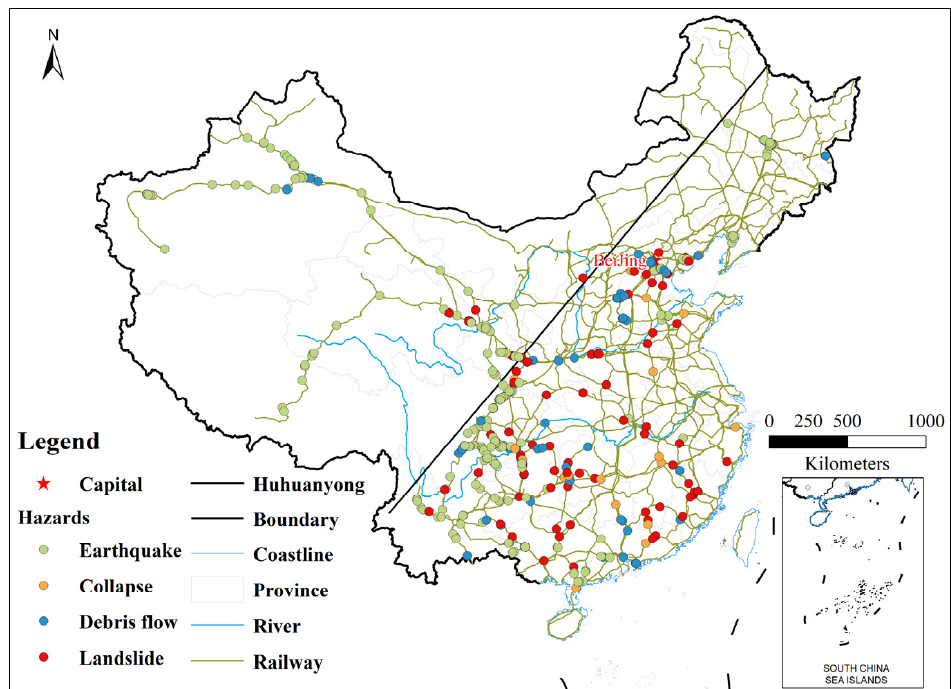
Figure 7. Spatial Distribution of the Railway Geological Disastrous Accidents.